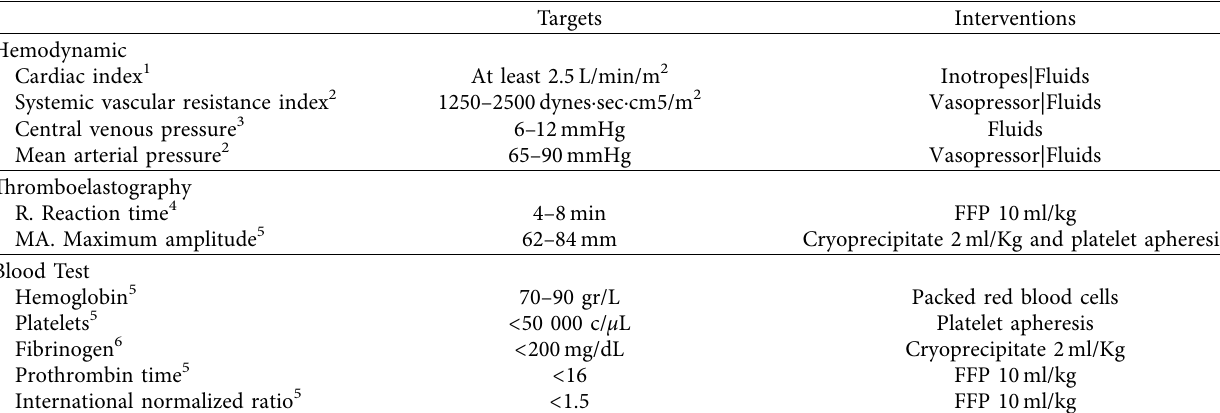
Table 1: Goal-directed